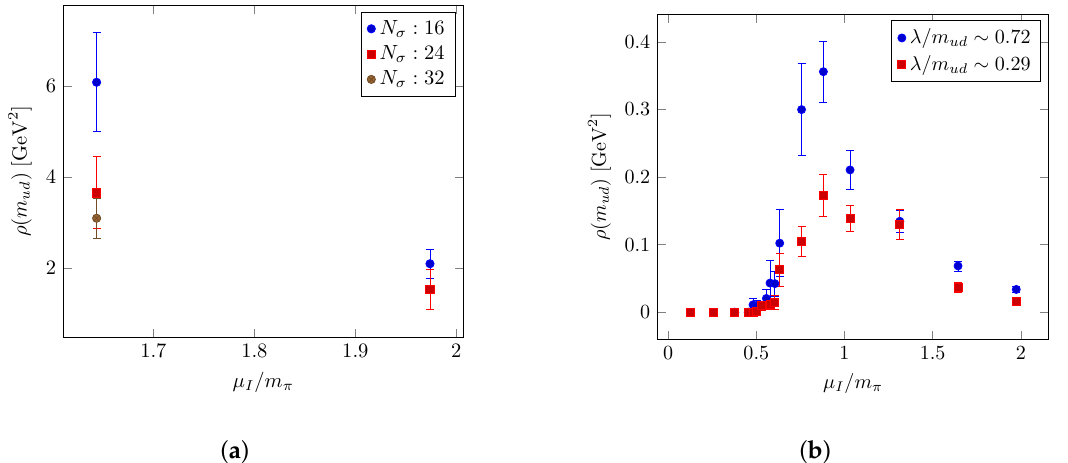
Figure 5. ( a ) ρ ( m ud ) as a function of µ I for N t = 6 and three different spatial volumes N s . ( b ) The λ dependence of results for T = 155